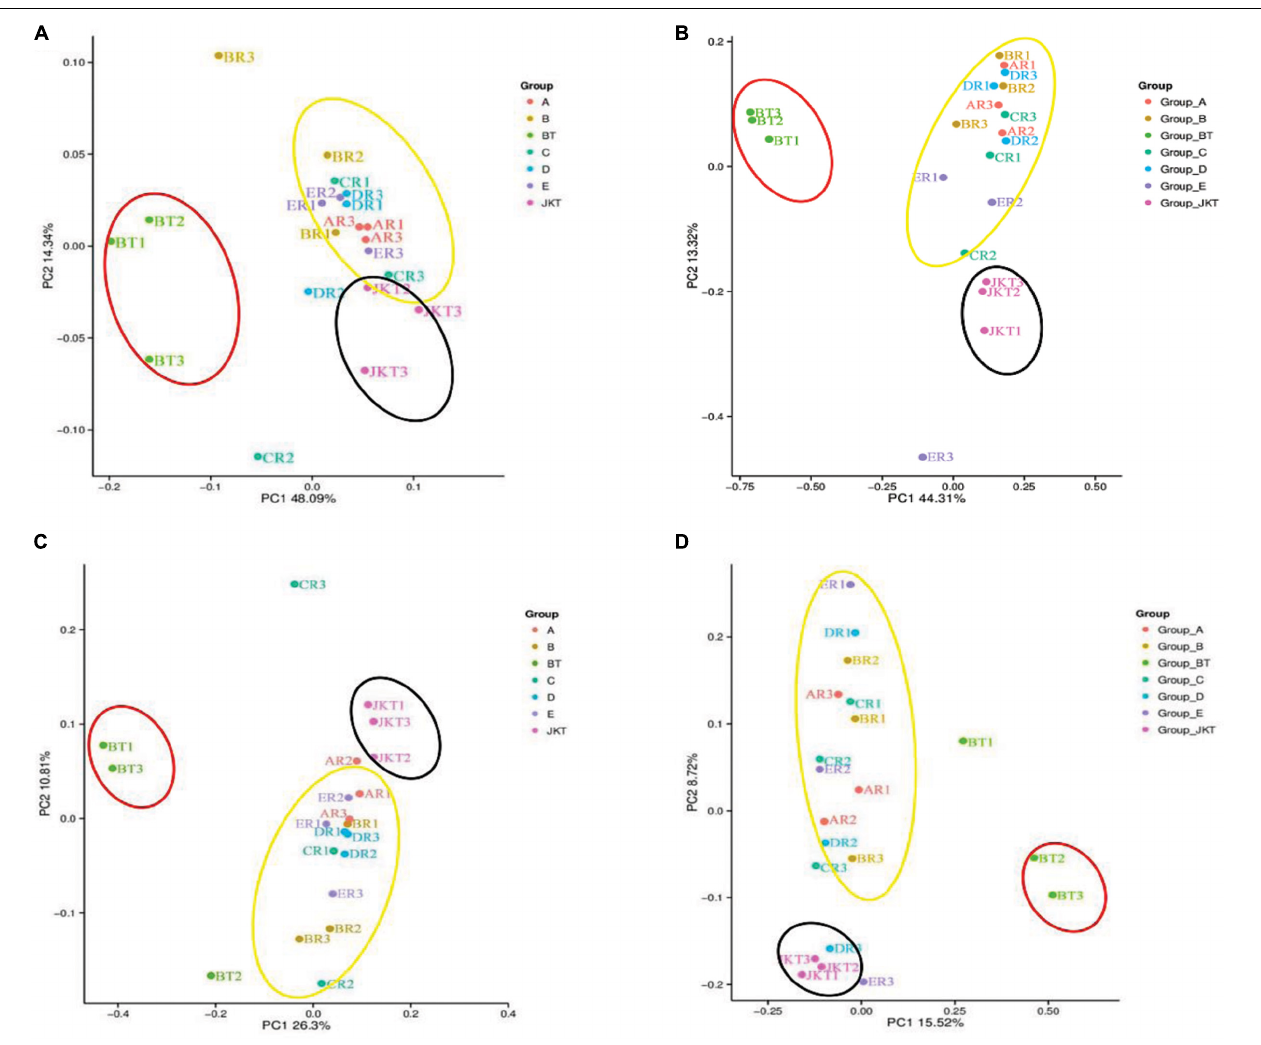
FIGURE 3 | Microbial community structures in the seven different soil samples. Weighted UniFrac principal coordinate analysis of bacterial (A) and fungal (B) community structures, and unweighted UniFrac principal coordinate analysis of bacterial (C) and fungal (D) community structures. Group A, B, C, and D represent four probiotic consortia, Group E represents the biopesticide, and Group BT and Group JKT represents the controls without any